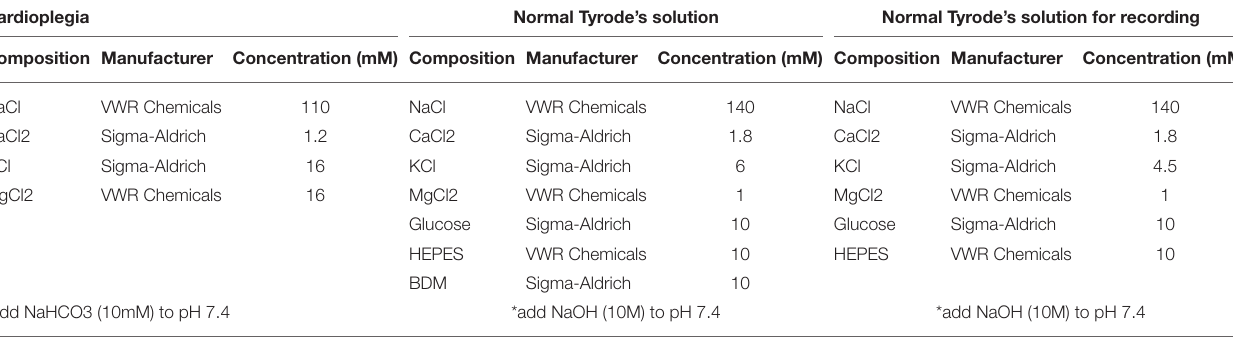
TABLE 1 | Components of solution. Cardioplegia Normal Tyrode’s solution Normal Tyrode’s solution for